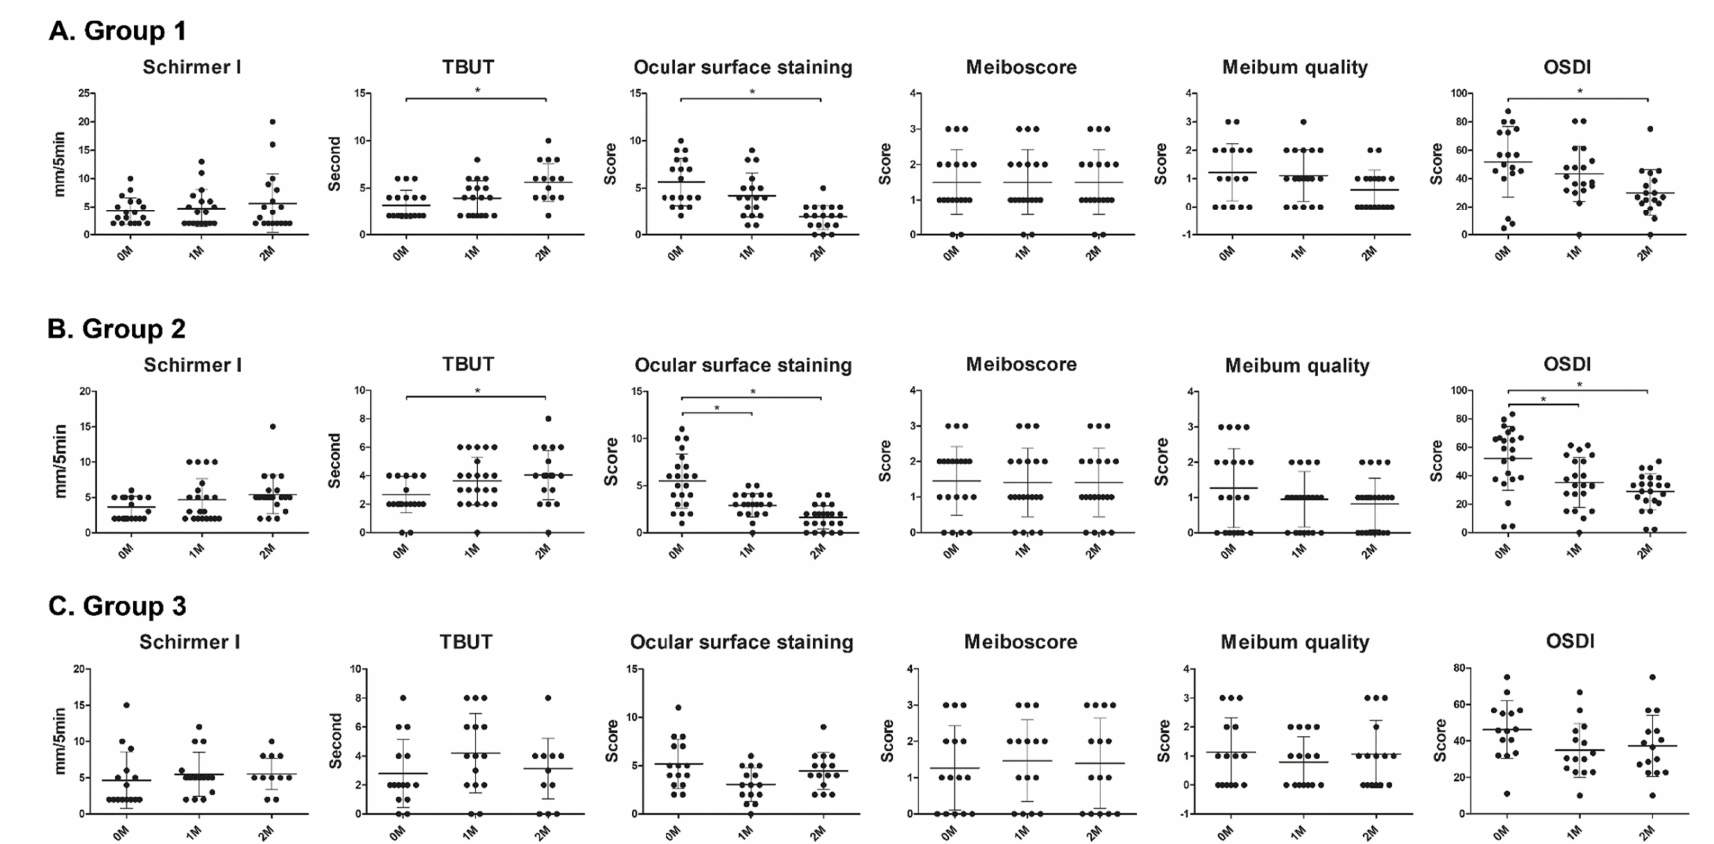
Figure 2. Changes in ocular surface-related parameters during a 2-month observation period in each group. Tear breakup time (TBUT), ocular surface staining (OSS) score and ocular-surface disease index (OSDI) were significantly improved in Groups 1 and 2 at 2 months when compared to the baseline and Group 2 also showed significant improvement in TBUT, OSS score and OSDI at 1 month. However, in Group 3, no changes were noted at 2 months in the Schirmer I test, meiboscore or meibum quality. The lines in the graph present the mean and standard deviation. * p < 0.05 by Dunn’s post-hoc comparison after Kruskal-Wallis test; Group 1, autologous serum eyedrops (ASEs) for 2 months without discontinuing glaucoma eyedrops ( n = 18); Group 2, ASEs for 2 months and discontinuing glaucoma eyedrops for the first month ( n = 22); Group 3: non-preservative artificial tears for 2 months and discontinuing glaucoma eyedrops for the first month ( n =